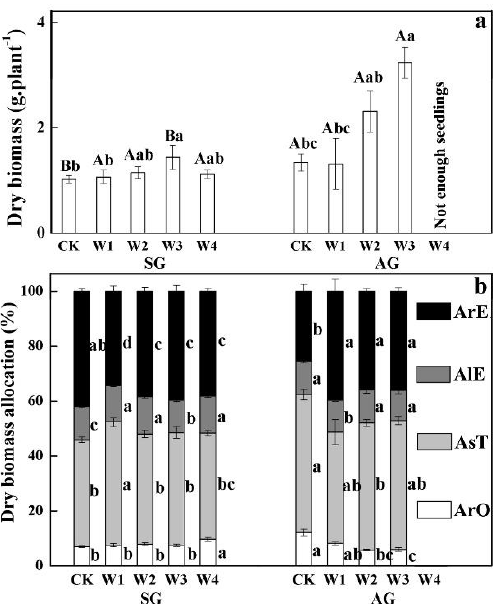
Figure 3. Effects of extreme precipitation on dry biomass accumulation ( a ) and biomass allocation ( b ) of spring-germinated (SG) and autumn-germinated (AG) plants of Erodium oxyrhynchum . ArO, allocation of biomass to roots; AsT, allocation of biomass to stems; AlE, allocation of biomass to leaves; ArE, allocation of biomass to reproductive organ. CK, control treatment; W1, +30% extreme precipitation; W2, +100% extreme precipitation; W3, +200% extreme precipitation; W4, maintenance of field capacity by increasing precipitation every three days. Different lowercase letters indicate significant differences ( p < 0.05) among CK, W1, W2, W3, and W4 for SG and AG, and different uppercase letters significant differences between SG and AG for the same extreme precipitation treatment. Moreover, W4 treatment did not have enough seedlings for statistical analysis.